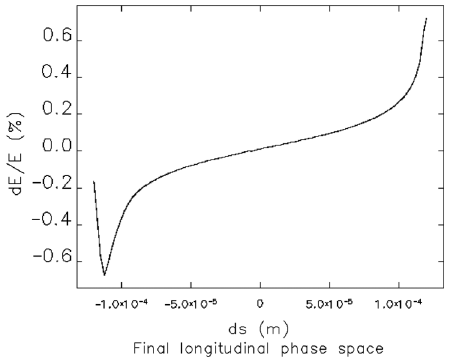
FIG. 4. A typical CSR wakefield induces energy variation along a 1 ps electron bunch. The head and tail of the bunch, respectively, gain and lose